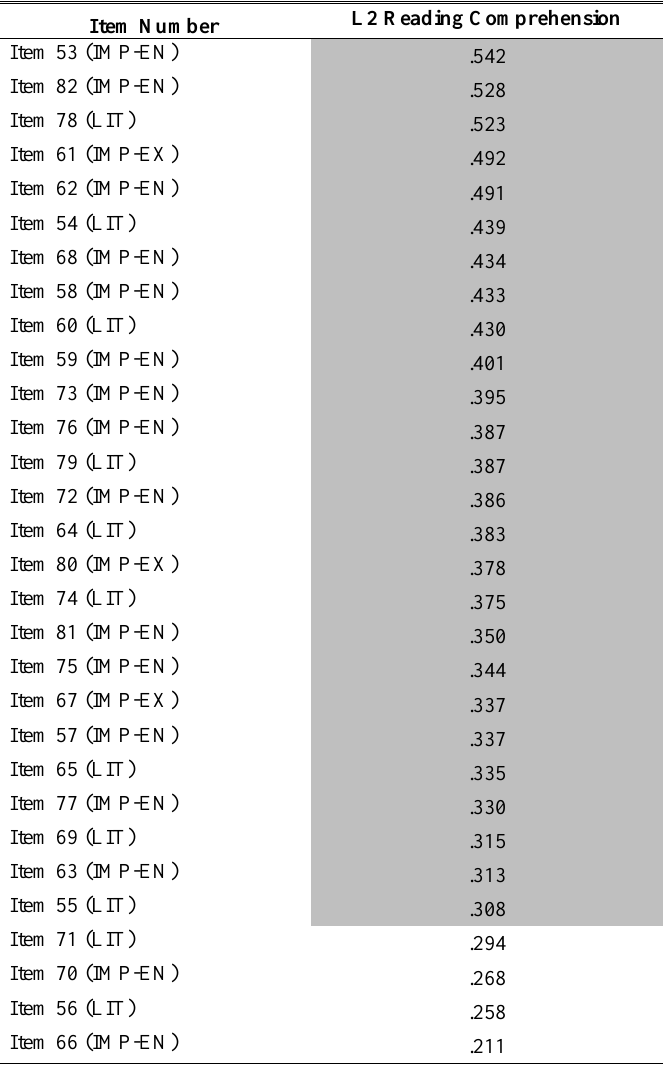
EFA Results for the Reading Test: 1-factor